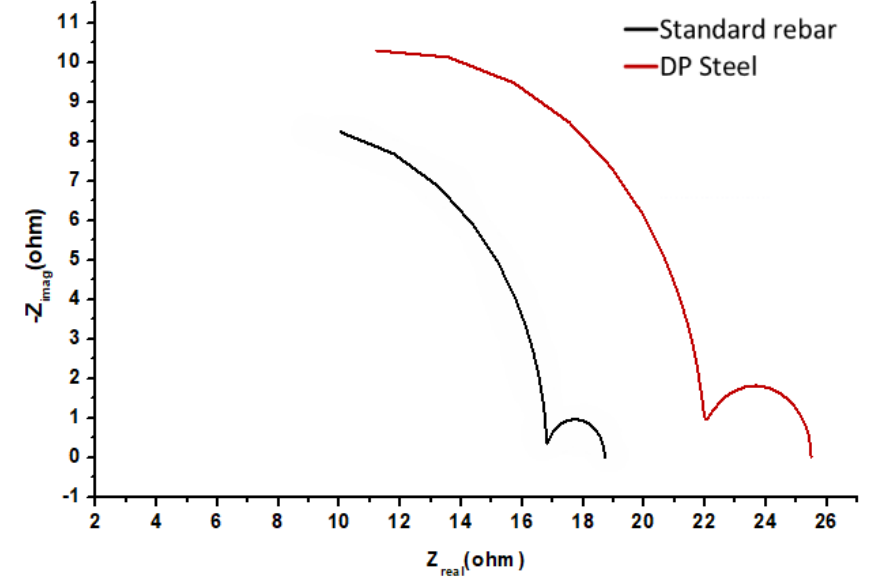
Figure 6. Comparison of the potentiodynamic polarization results for standard rebar and DP steel recorded in saturated Ca(OH) 2 (pH = 12.5) + 0.2% Cl − solution.